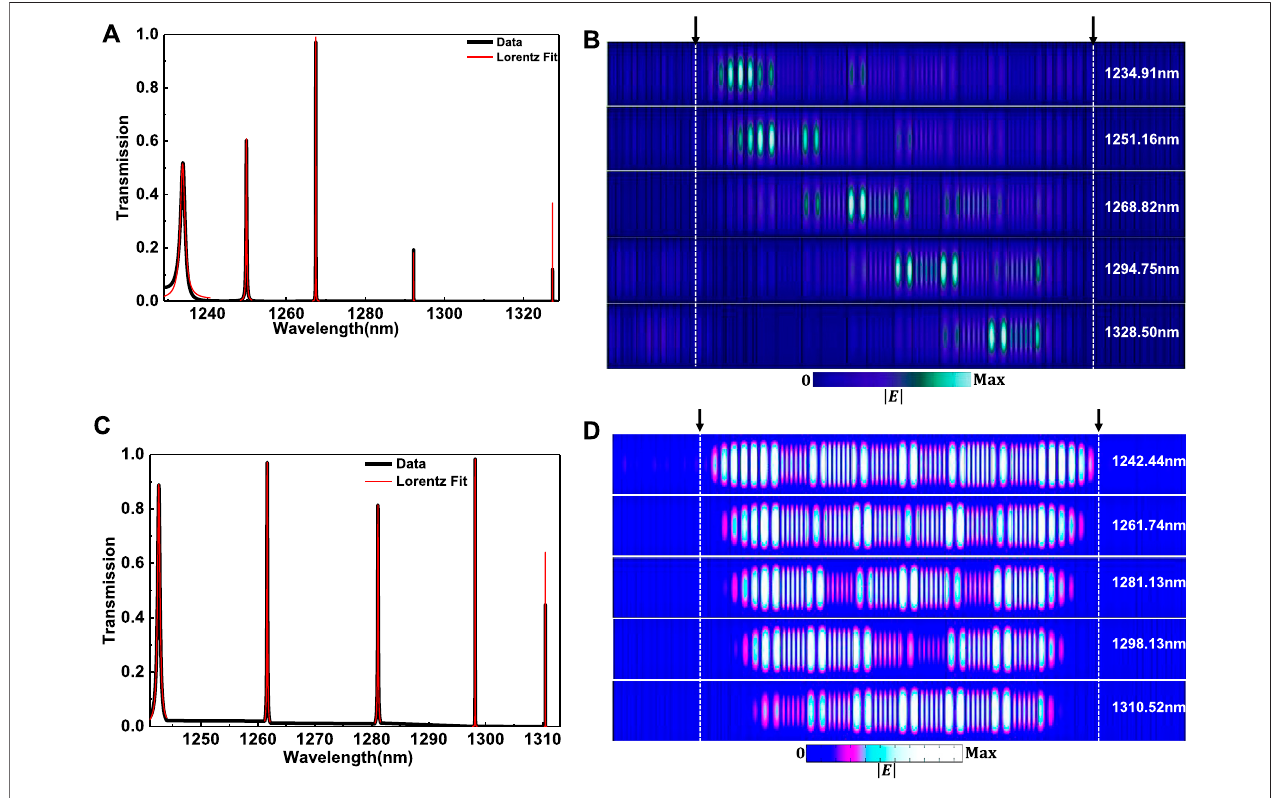
FIGURE 2 | (A) The transmission spectrum of the unidirectional rainbow trapping structure with the Lorentzian- fi tting curves when d SiO 765 nm and d Si from 1,000 to 1,100 nm; (B) the electric fi eld |E| intensity distribution of the unidirectional rainbow trapping at wavelengths 1234 . 91 , 1251 . 16 , 1268 . 82 , 1294 . 75 , and1328 . 50 bynm; (C) the transmission spectrum of the bidirectional rainbow trapping structure with the Lorentzian- fi tting curves of d SiO varying from 740 to 765 nm and d Si is fi xed at 1,060 nm; (D) the |E| intensity distribution of the bidirectional rainbow trapping at wavelengths 2 1242 . 44 , 1261 . 74 , 1281 . 13 , 1298 . 13 , and 1310 . 52 by